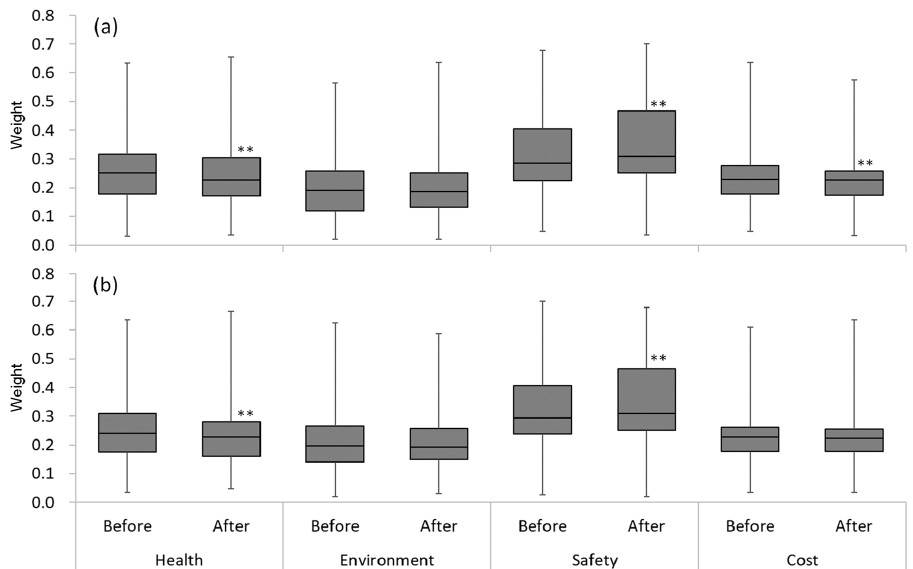
Figure 4. Weights of evaluation criteria by sex: ( a ) men; ( b ) women (left: before watching video; right: after watching video). Two-sided test, alternative hypothesis: “before watching video” ≠ “after watching video”, ** p < 0.01. In the box plots, the boundary of the box closest to zero indicates the 25th percentile, the black line within the box marks the median, and the boundary of the box farthest from zero indicates the 75th percentile. Whiskers above and below the box indicate the 95th and 5th percentiles, respectively.